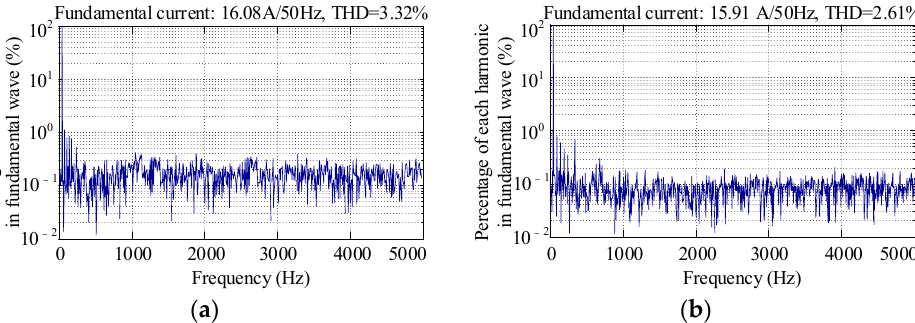
of the two NPV control strategies in the a